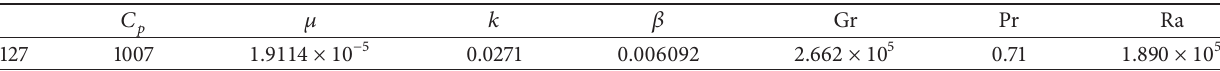
Table 3: Thermophysical properties of air